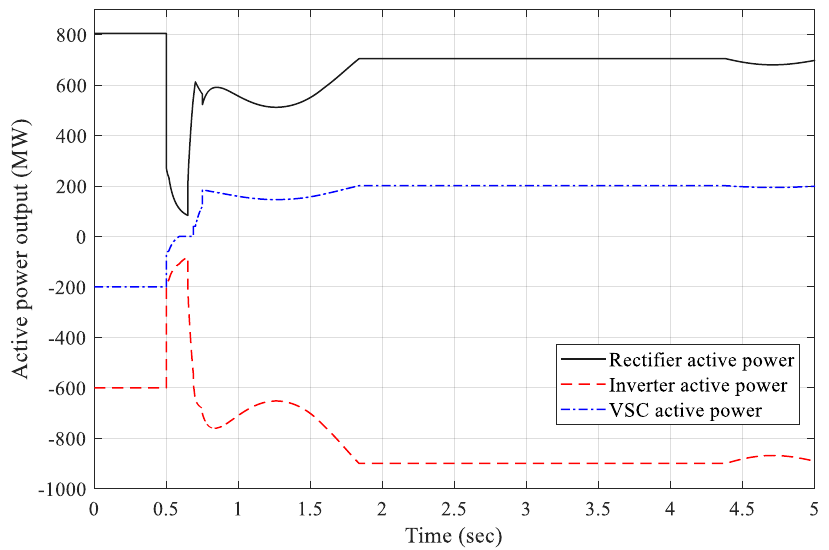
Figure 21. The active power output for each converter with the overload.